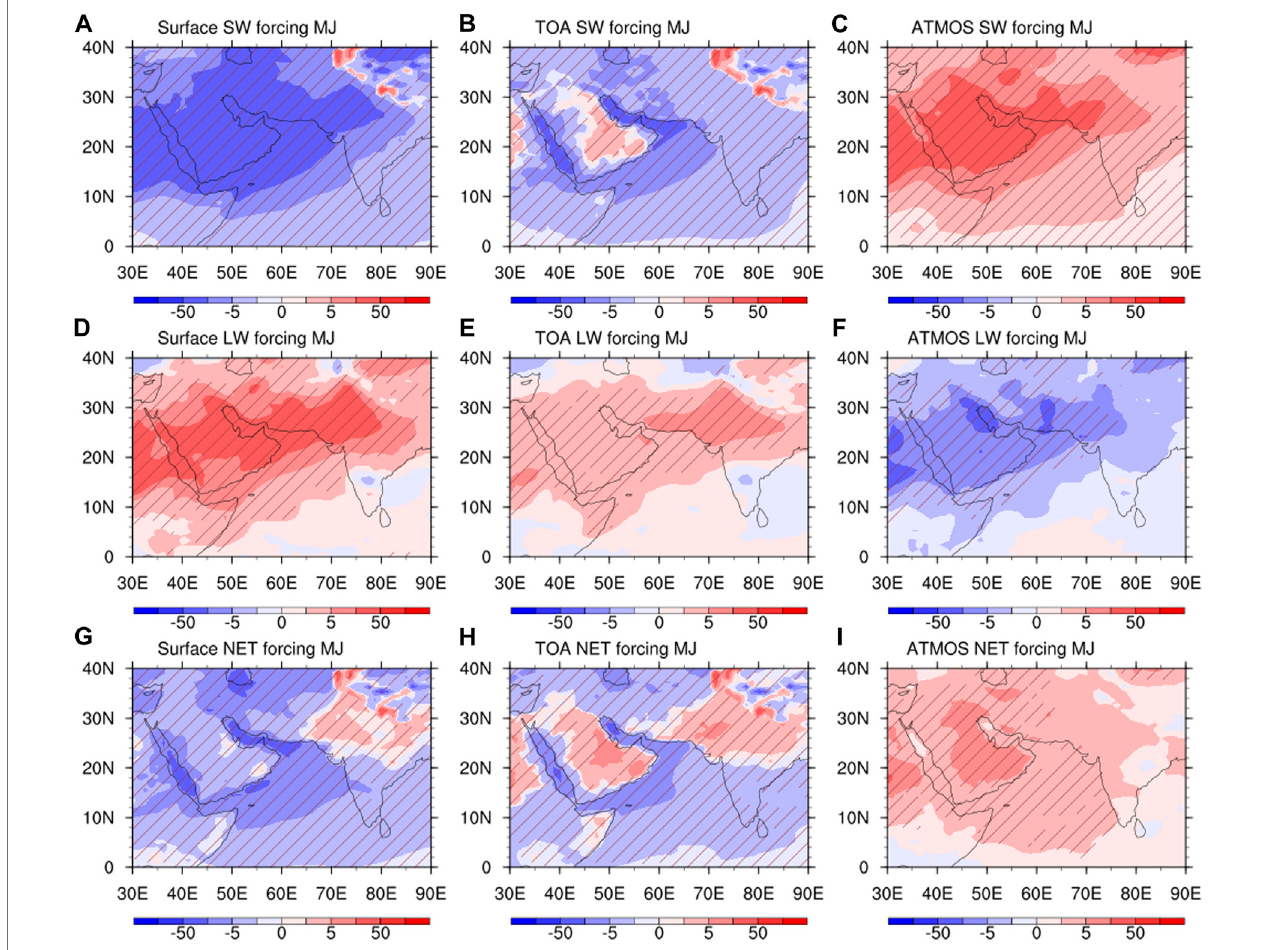
FIGURE 8 | The dust DRE induced changes (UMD – UMN) in clear – sky short-wave [SW, (A – C) ], long-wave [LW, (D – F) ] and net [SW + LW, (G – I) ] radiative forcing (W/m 2 ) at the surface (A,D,G) , at the TOA (B,E,H) and in the atmosphere (C,F,I) in the early monsoon. Brown lines represent the values statistically signi fi cant at the 0.1